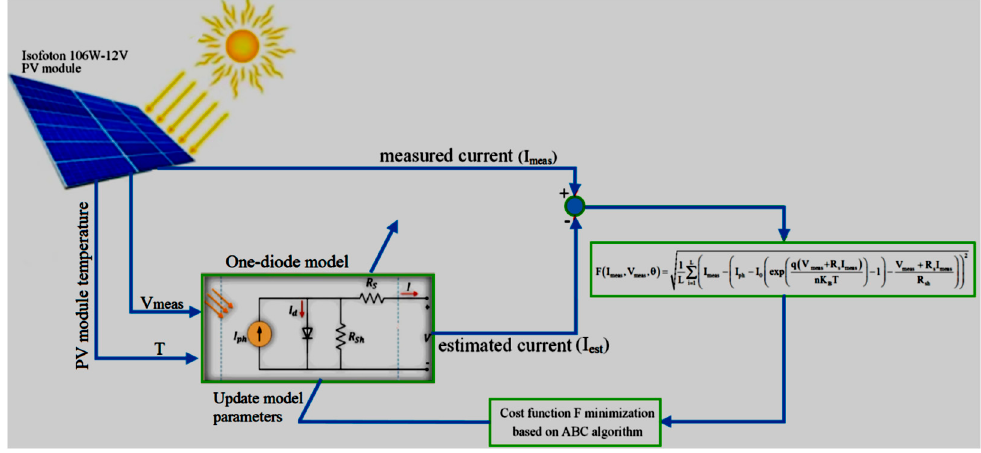
Figure 2. Calculation of equivalent circuit parameters [22].